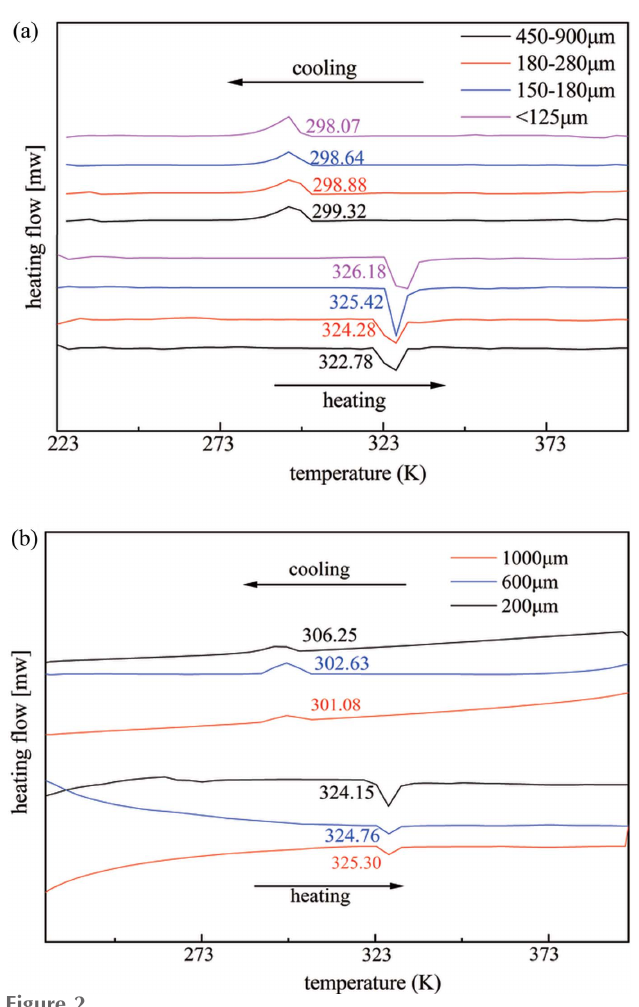
Figure 2 DSC thermograms of heating and cooling cycles of ( a ) polycrystalline powders of different sizes in the same batch samples and of ( b ) single crystals of different